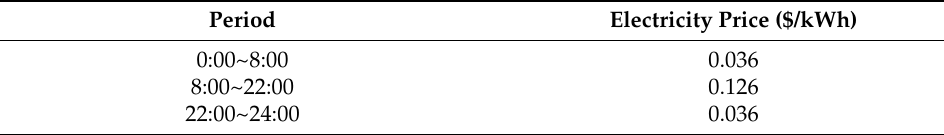
Table 3. Parameters of Time-of-use Tariffs.